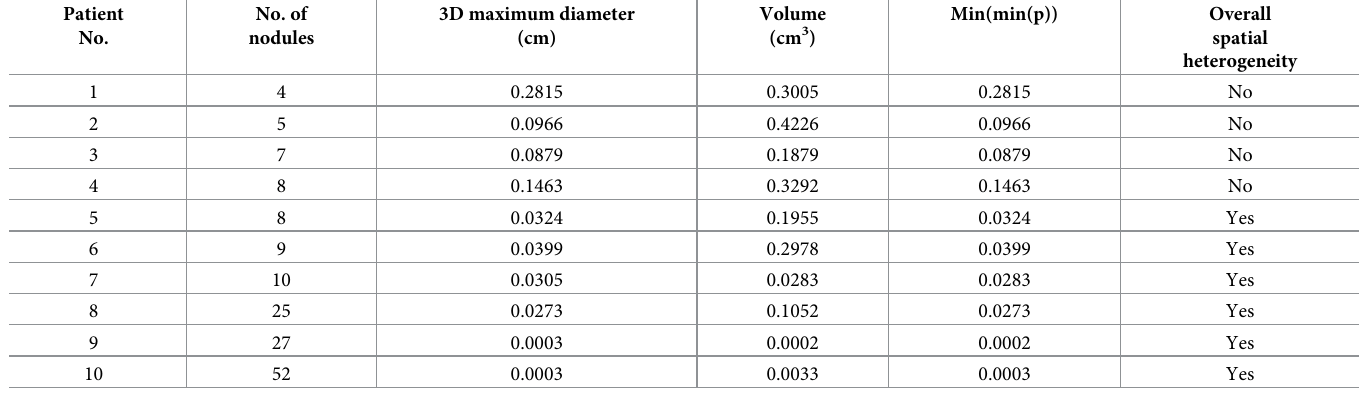
Table 3. CT spatial tumor heterogeneity of each patent’s all metastatic nodules in 10 patients. Patient